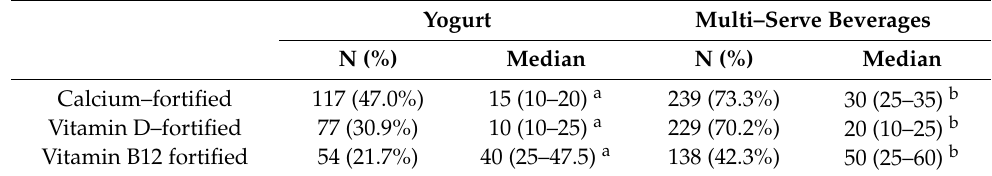
Table 5. Medians (Q1–Q3) of fortification levels of calcium, vitamin D and vitamin B12 (expressed as % DV) in fortified non-dairy yogurt alternatives and the fortified non-dairy, plant-based multi- serve beverages.